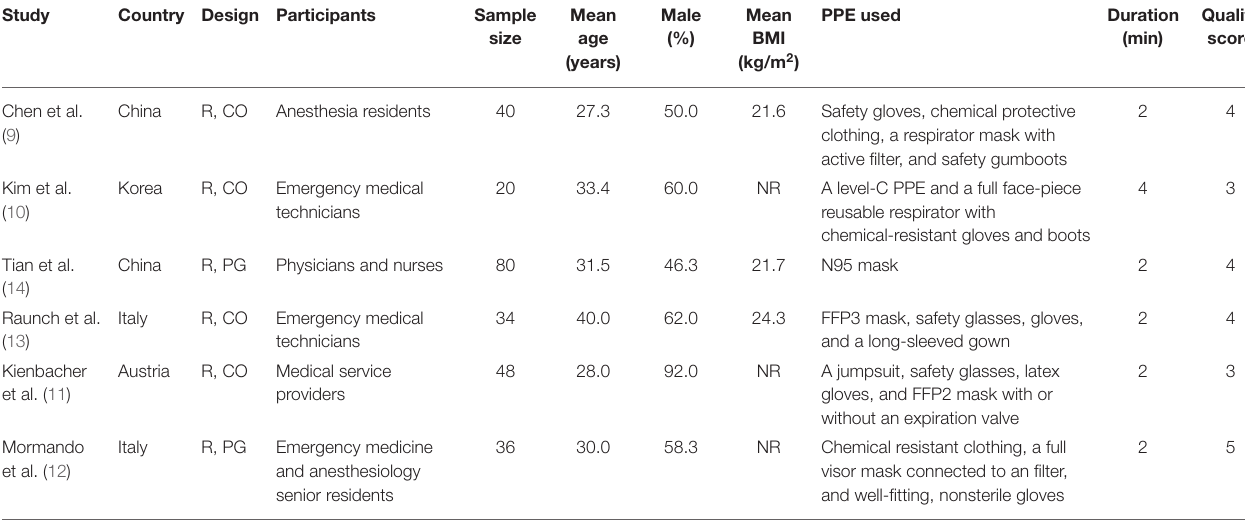
TABLE 1 | Characteristics of the included RCTs.